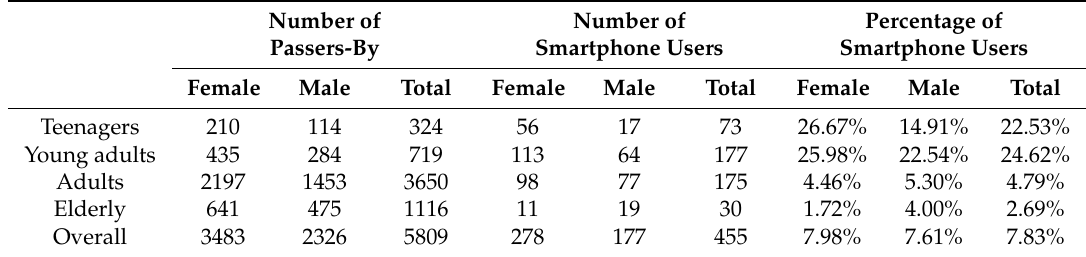
Table 2. Number of all passers-by and smartphone users by predicted age groups and